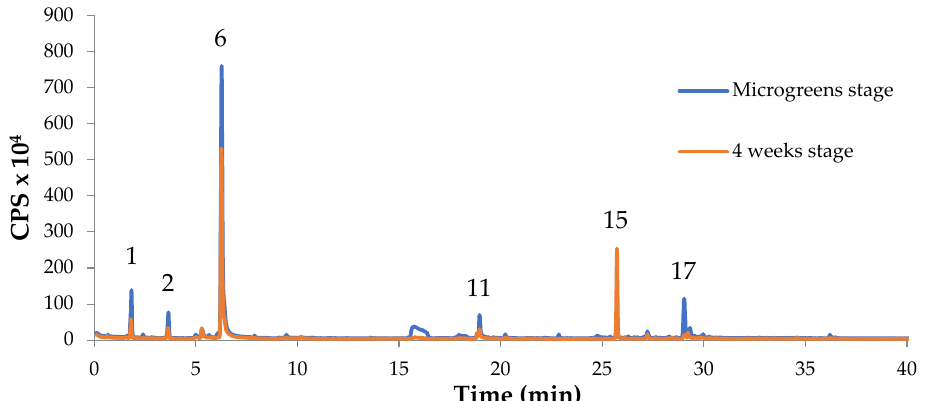
Figure 3. Comparison of VOCs of Chinese red basil (var. crispa ) at microgreens stage and after further 4 weeks. The numbers of the peaks correspond to the volatile compounds identified (see Table 3). The leaves of Chinese green basil (var. frutescens ) microgreens produce fewer VOCs but